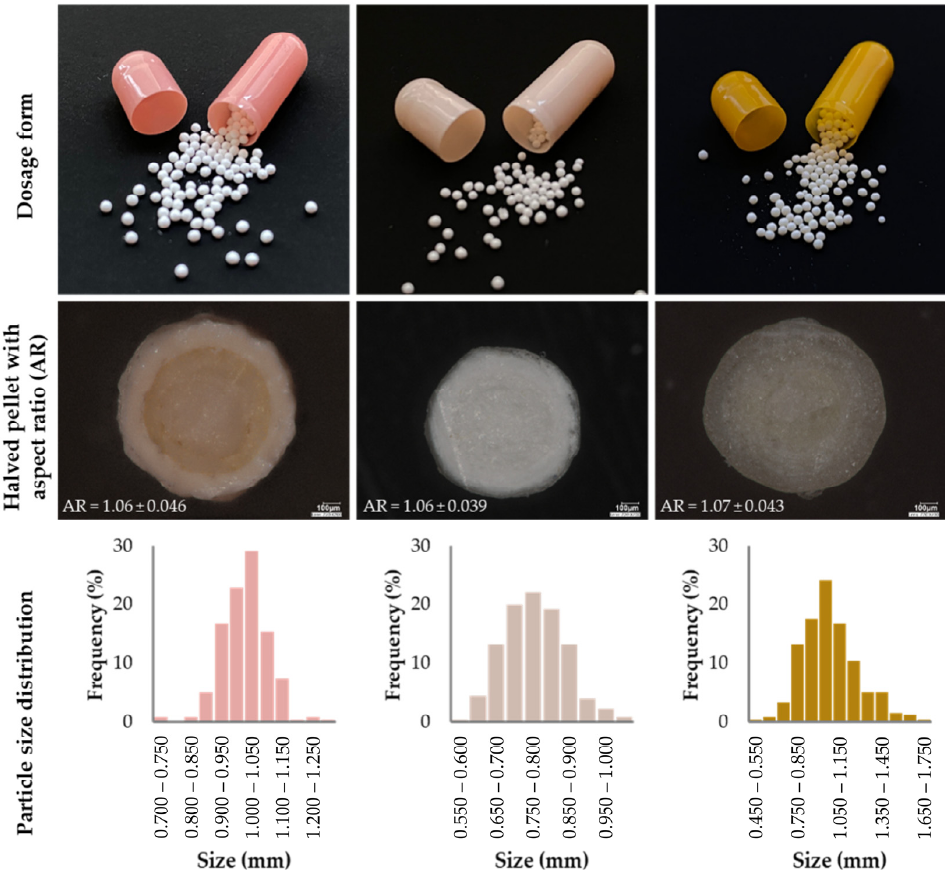
Figure 13. Microscopic photos and image analysis results (AR: aspect ratio; particle size distribution) of three commercially available products (1st column: Emozul ® (KRKA); 2nd column: Olwexya (KRKA); 3rd column: Cetebe (GSK); Keyence VHX 970 digital microscope; software: ImageJ; n = 200; Avg. ± SD evaluation of own experimental data).